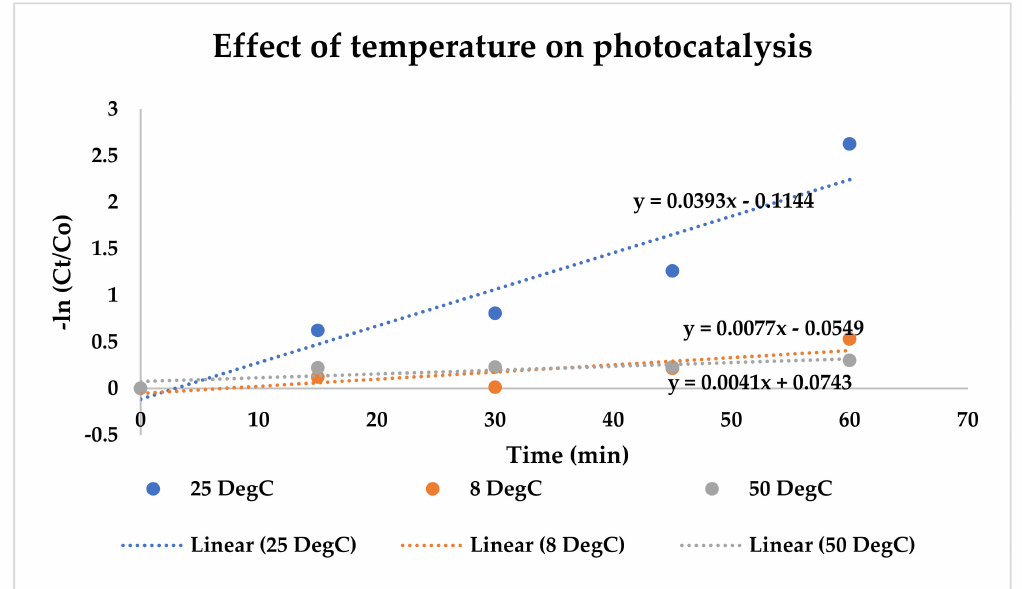
Figure 9. Photocatalytic reduction of Cr(VI) at varying